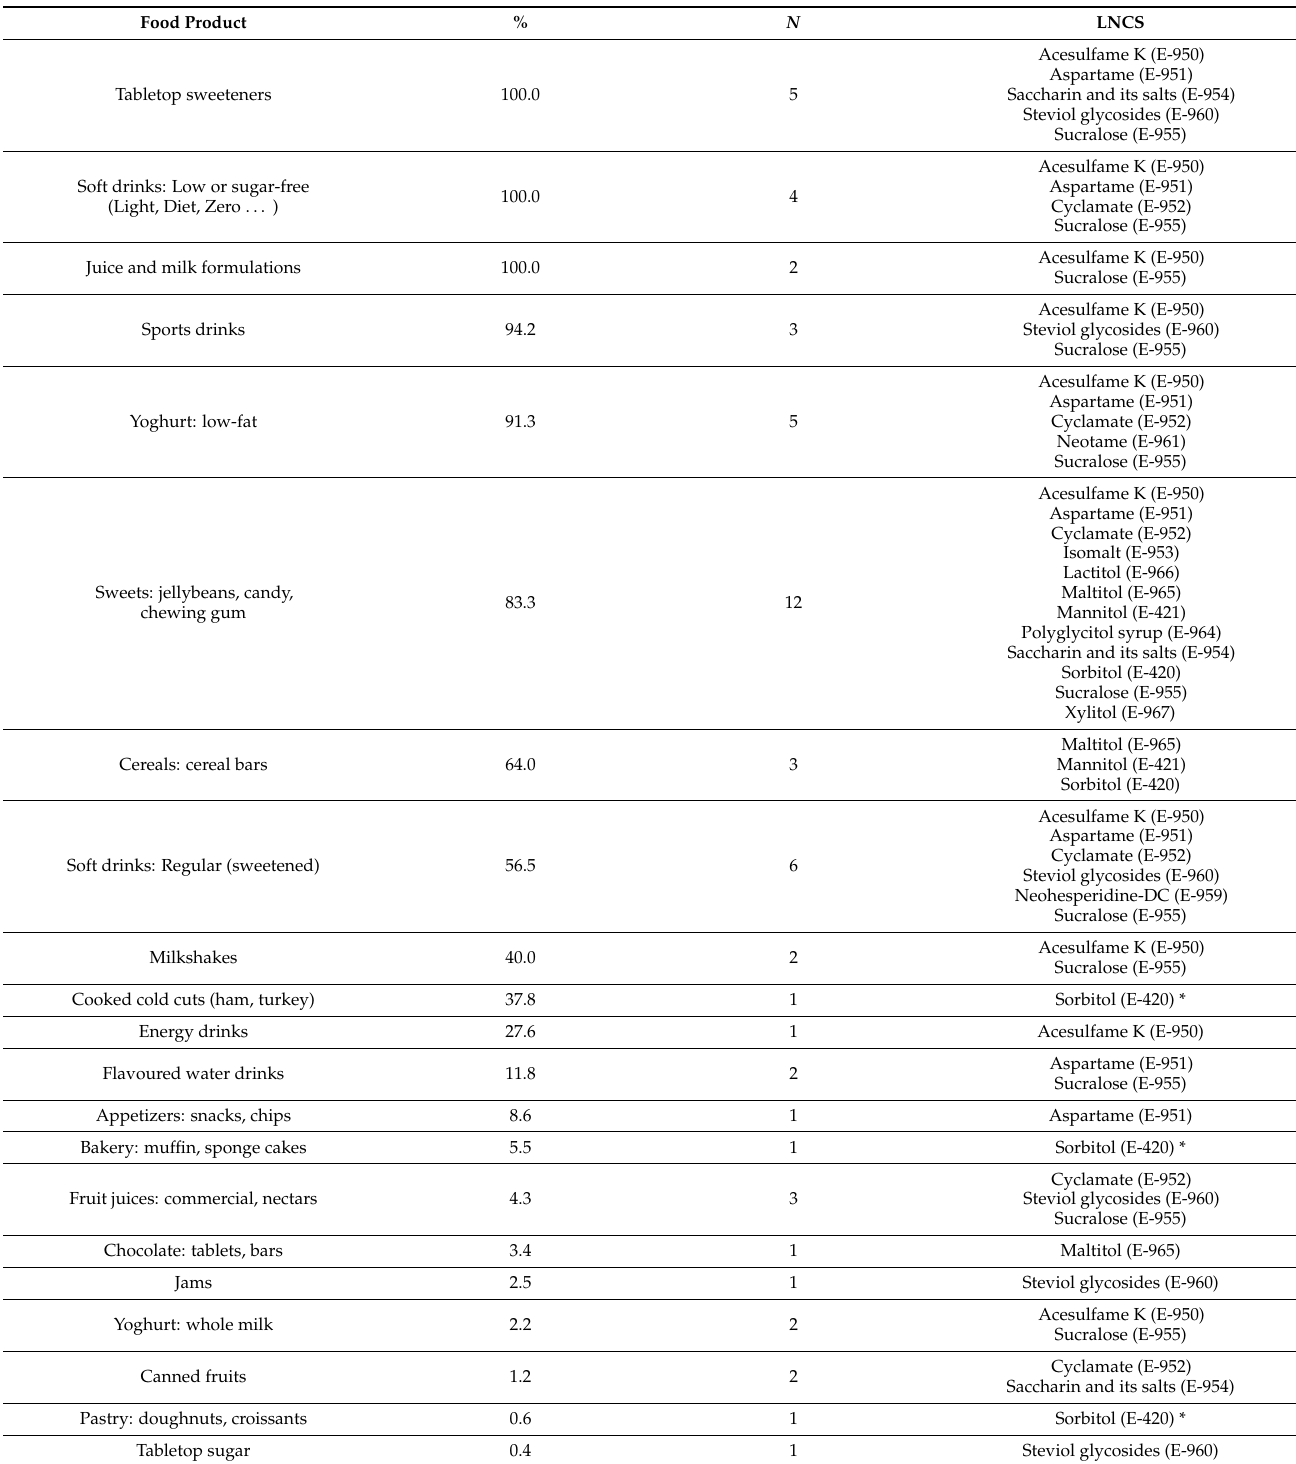
Table 3. Presence and type of low- and-no-calorie sweeteners (LNCS) in all food products contributing to LNCS consumption. Food Product % N LNCS Tabletop sweeteners